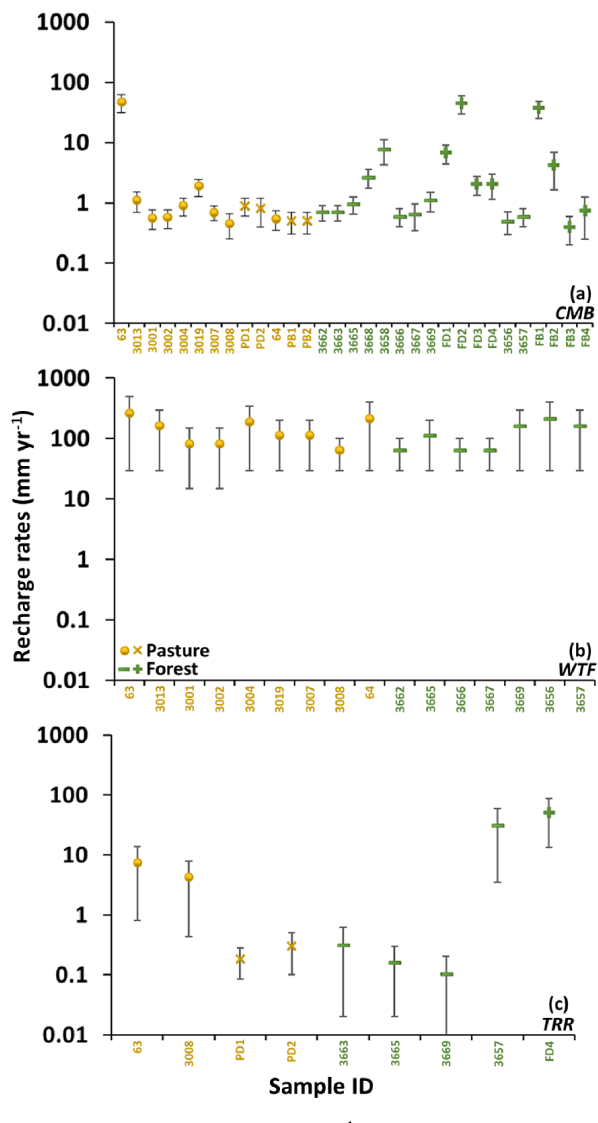
Figure 7. Recharge rates (in mmyr − 1 ) estimated from (a) CMB, (b) WTF and (c) TRR. PD and FD are for the shallow groundwater in the pasture drainage and forest drainage areas, respectively. Bars indicate the ranges of recharge rates from Table